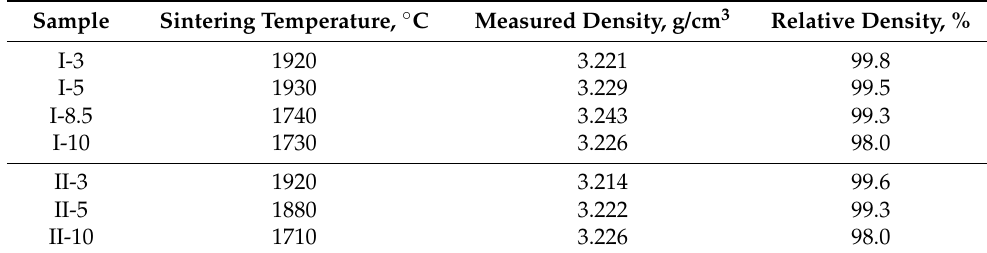
Table 2. Sintering temperature, measured, and relative densities of the ceramic samples. Sample Sintering Temperature, °C